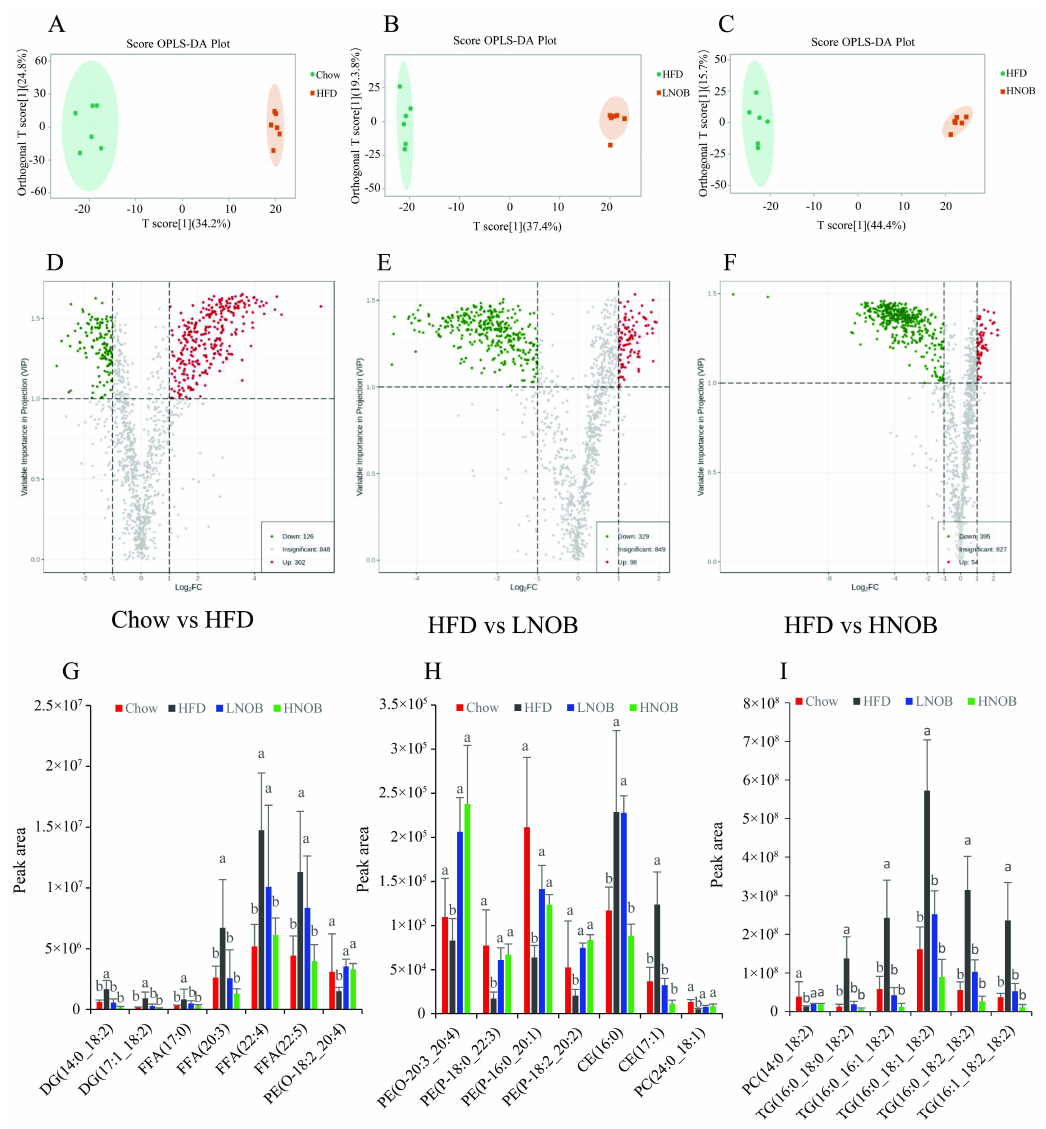
Figure 4. Analysis of markedly differential hepatic lipid species in Chow vs. HFD, HFD vs. LNOB, and HFD vs. HNOB. The OPLS-DA scores ( A – C ) and volcano plot ( D – F ) analysis of Chow vs. HFD, HFD vs. LNOB, and HFD vs. HNOB, respectively. The obviously differential lipid species were selected out by using the criteria of FC ≥ 2 or ≤ 0.5 and VIP ≥ 1 in the volcano plot, where the obviously differential lipid species were shown using a red (up) or green (down) dot, whereas a gray dot represented no significant difference of lipid species. ( G – I ) The potential lipid biomarkers in response to the beneficial effects of NOB in HFD-induced mice were selected out by using the criteria of fold change ≥ 2 or ≤ 0.5 and VIP ≥ 1. Data are shown as mean ± SD ( n = 6). Data with different letters (a, b) represent significant difference ( p < 0.05), whereas bars with the same letter correspond to values that exhibit no significant differences.